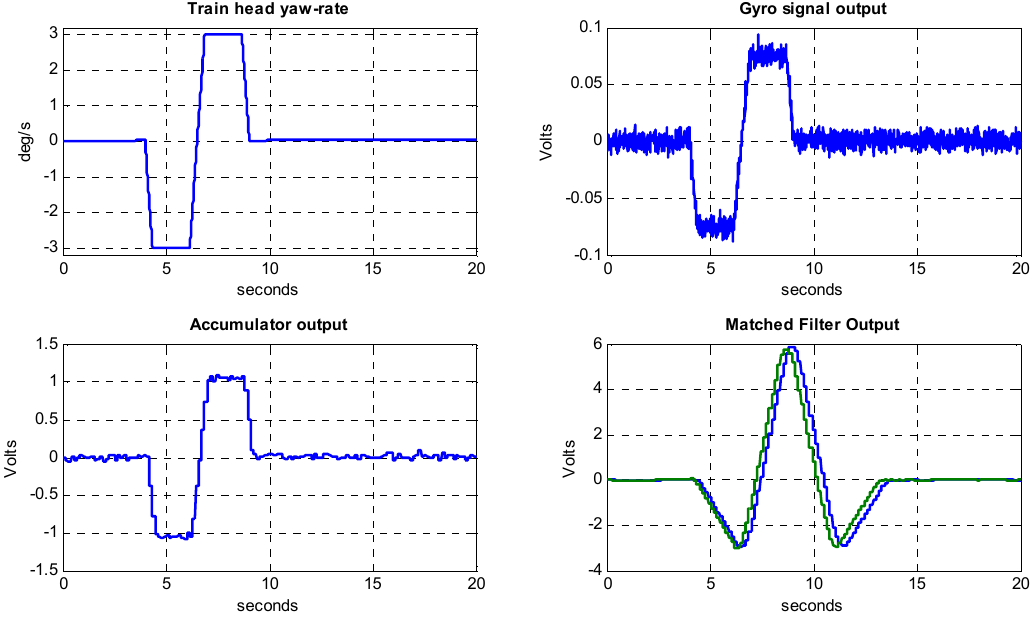
Figure 14. MATLAB ® -Simulink results of a 50 km/h simulation. Five signals are shown corresponding to the output ports 1 to 5 of the Simulink model. Top-left: port 1: actual yaw rate. Top-right: port 2: gyro output. Bottom-left: port 3: Accumulator output. Bottom-right: ports 4, 5: Blue is the ideal Matched Filter output and Green is the rectangular approximated Matched Filter.